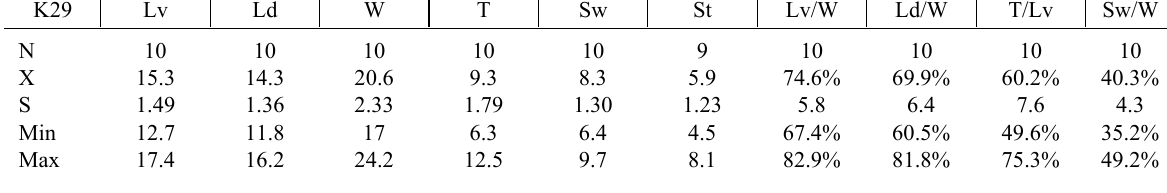
Table 4. Basic statistics of 10 shells of Stegocornu denisae sp. nov . ; Llandovery, mid-late Aeronian, Niur Formation, sample K29, Boghu Mountains